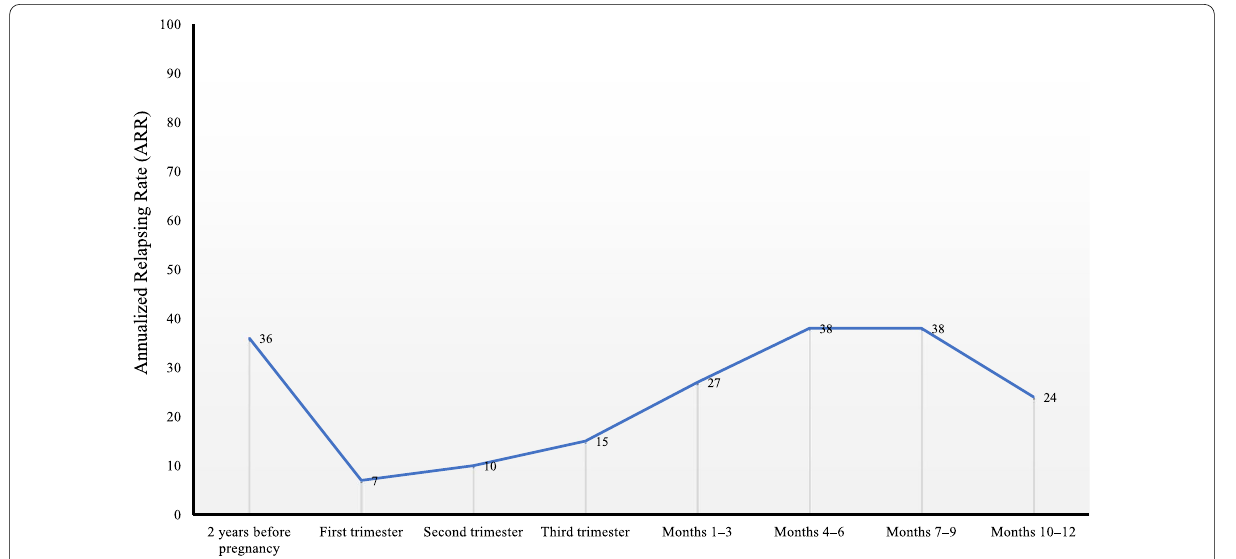
Fig. 1 The pattern of annualized relapsing rate before, during and after pregnancy